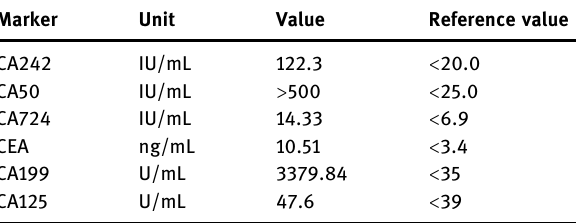
Table 1: Tumor marker levels at admission